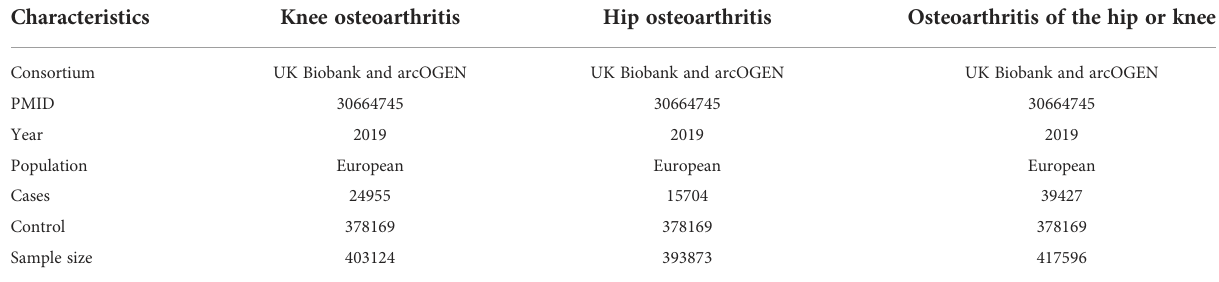
TABLE 2 Overview of genome-wide association studies used in the analyses for the outcomes.